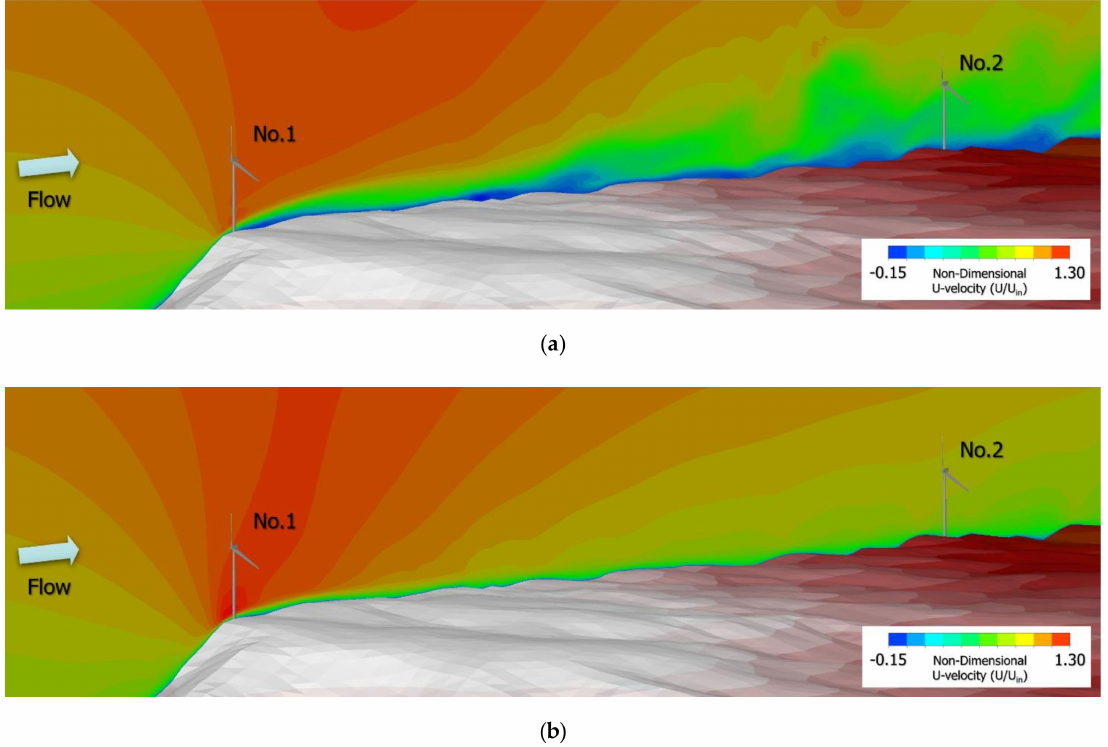
Figure 21. Instantaneous flow patterns of fully developed flow field, including the No. 1 (upstream) and No. 2 (downstream) wind turbines and the spatial distribution of the corresponding